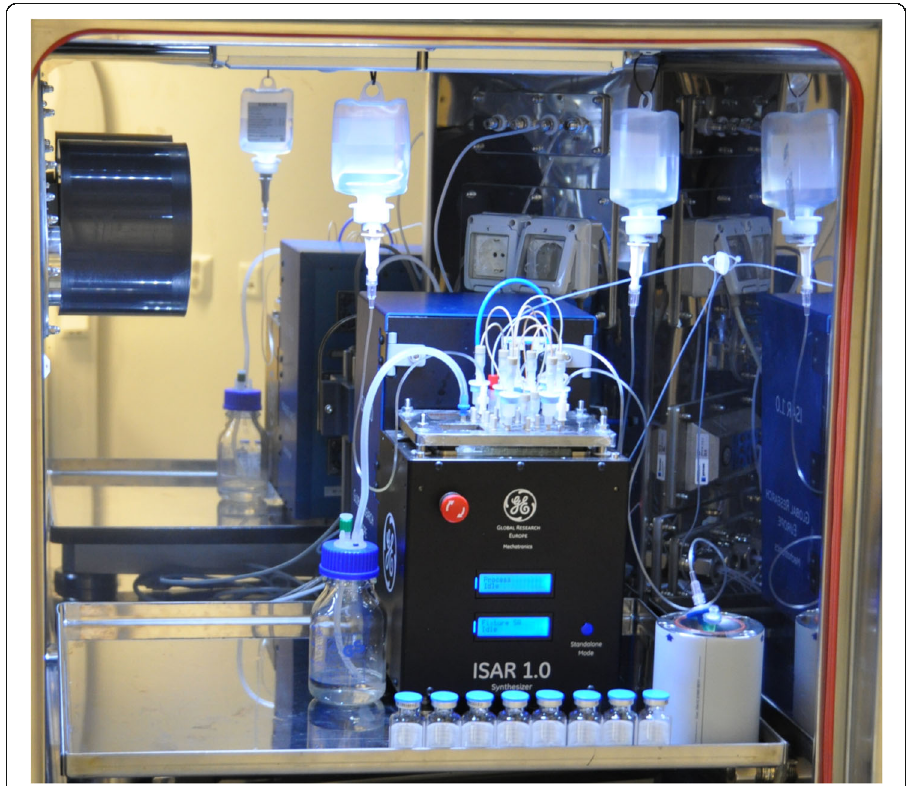
Fig. 8 ISAR unit installed in hot-cell similar to the set up at the University of Michigan PET Center. Installation at the University involved placing the ISAR module in a hot-cell, connecting it to mains power, N 2 gas (6 bar), a control laptop (ethernet) and the delivery line from the [ 13 N]NH 3 target on the cyclotron. Installation was completed in less than 1